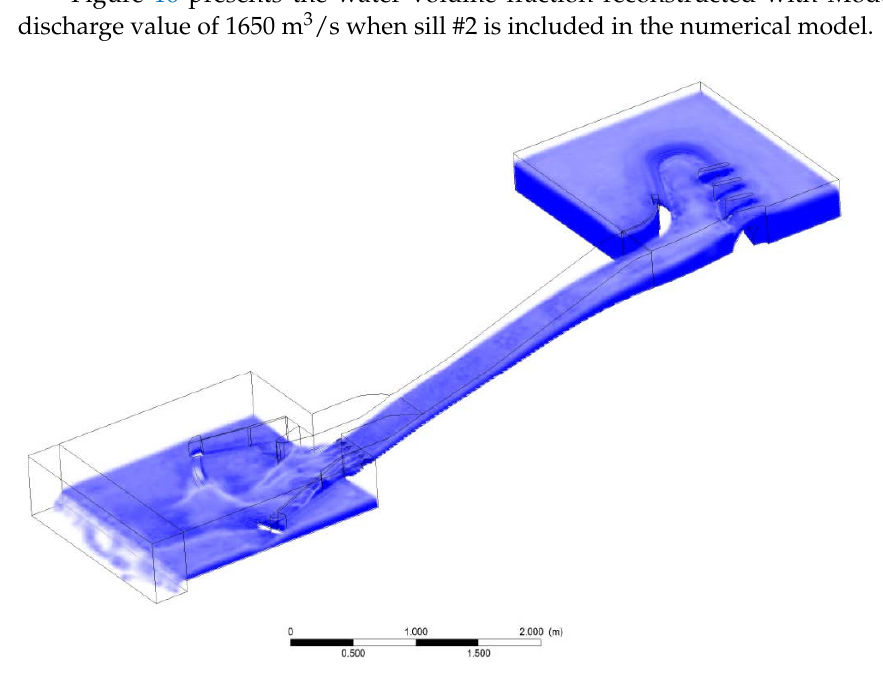
Figure 16. Water volume fraction reconstructed with Model #2 for a discharge value of 1650 m 3 /s and the presence of sill #2. Table 5. Height of the free surface inside the upstream tank, expected flow rate and the presence of sill #2 for Model #2.